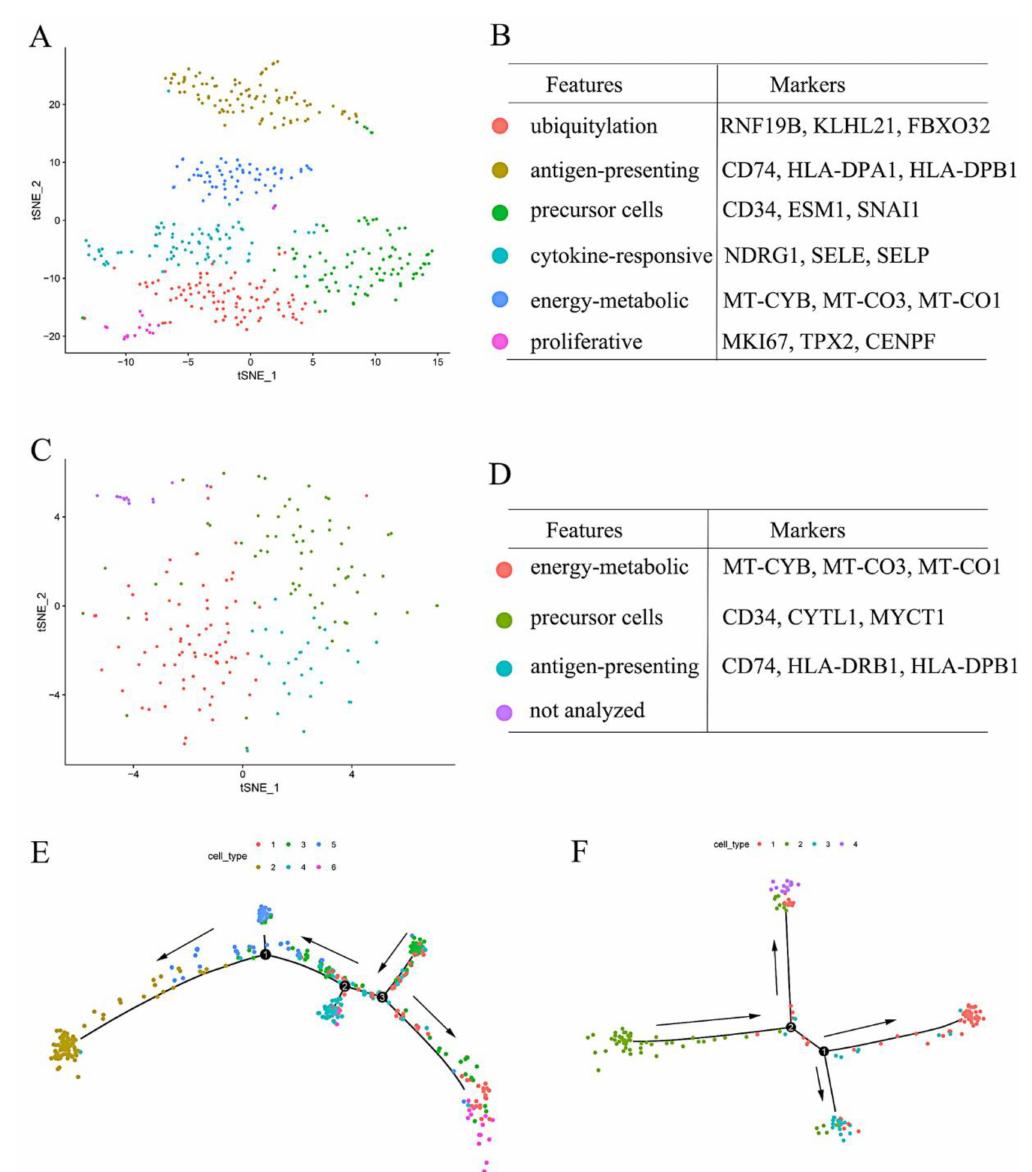
Figure 7. Clustering analysis of the upper and the lower endothelial cells: tSNE map, cluster visu- alization and its gene markers of the ( A,B ) upper; and ( C,D ) the lower endothelial cells. Trajectory analysis of the subsets in ( E ) the upper; and ( F ) the lower endothelial cells. Black arrow: develop- ment